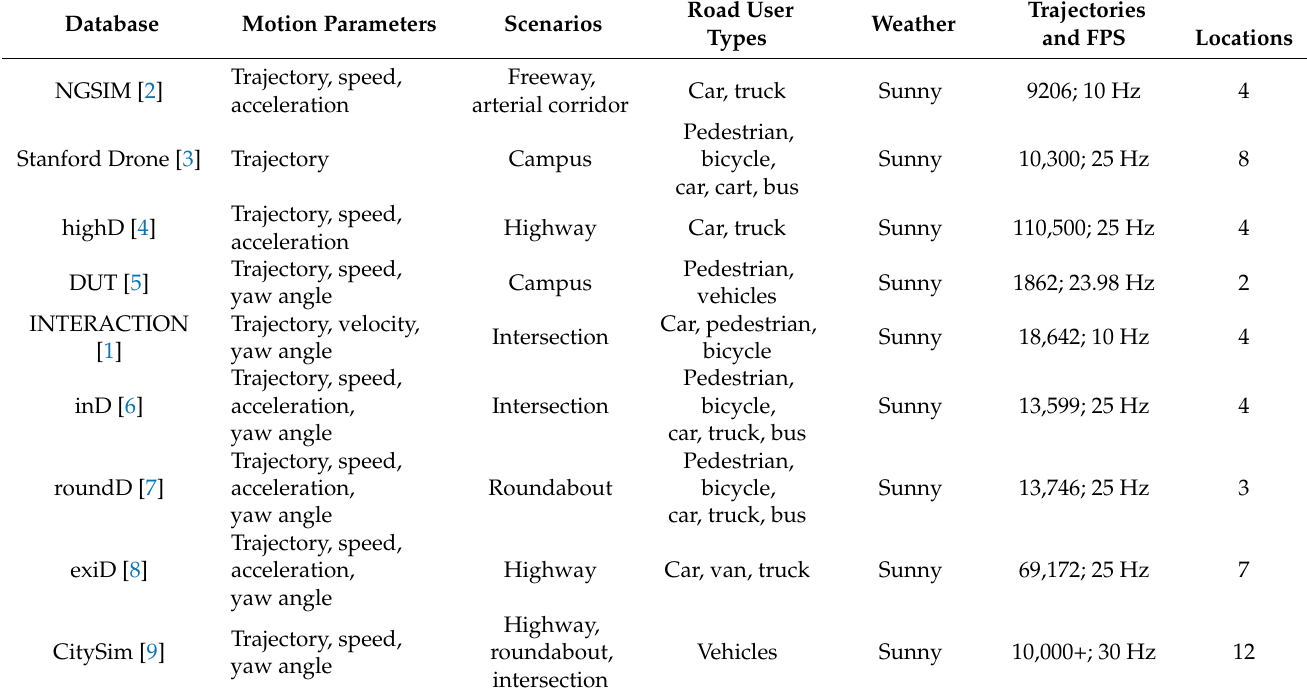
Table 1. Different aerial view vehicle motion